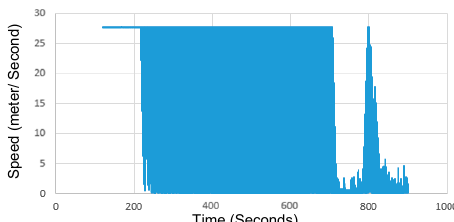
Figure 2. Speed data of a sample road generated by individual vehicles and collected by the nearest edge.